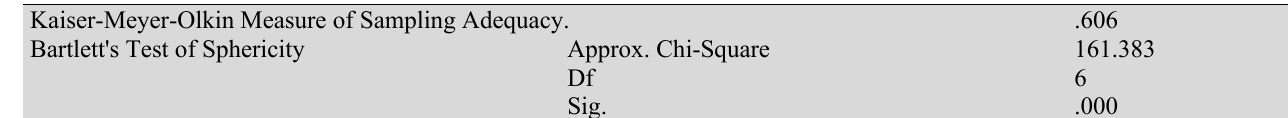
The results of KMO and Bartlett's Test Kaiser-Meyer-Olkin Measure of Sampling